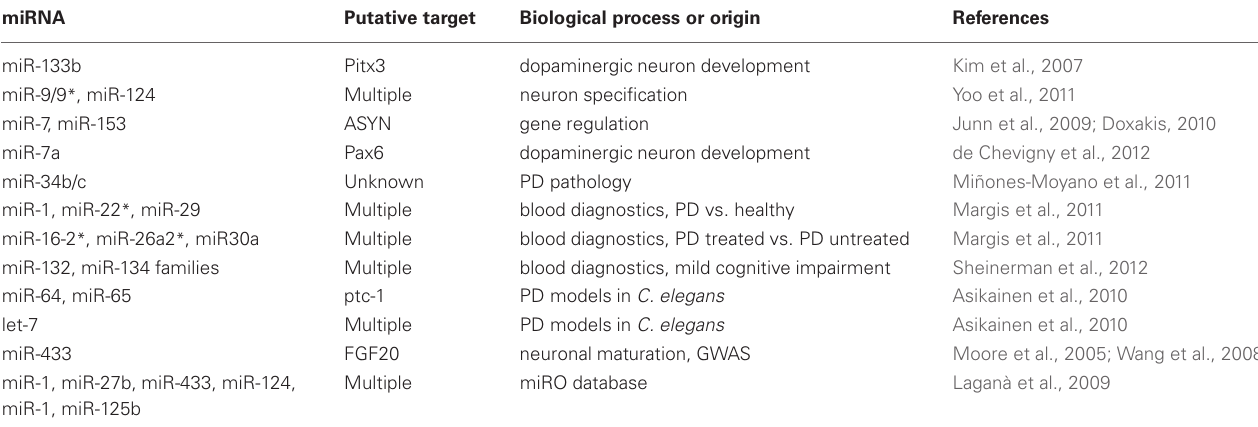
Table 1 | Summary of miRNAs linked to Parkinson’s